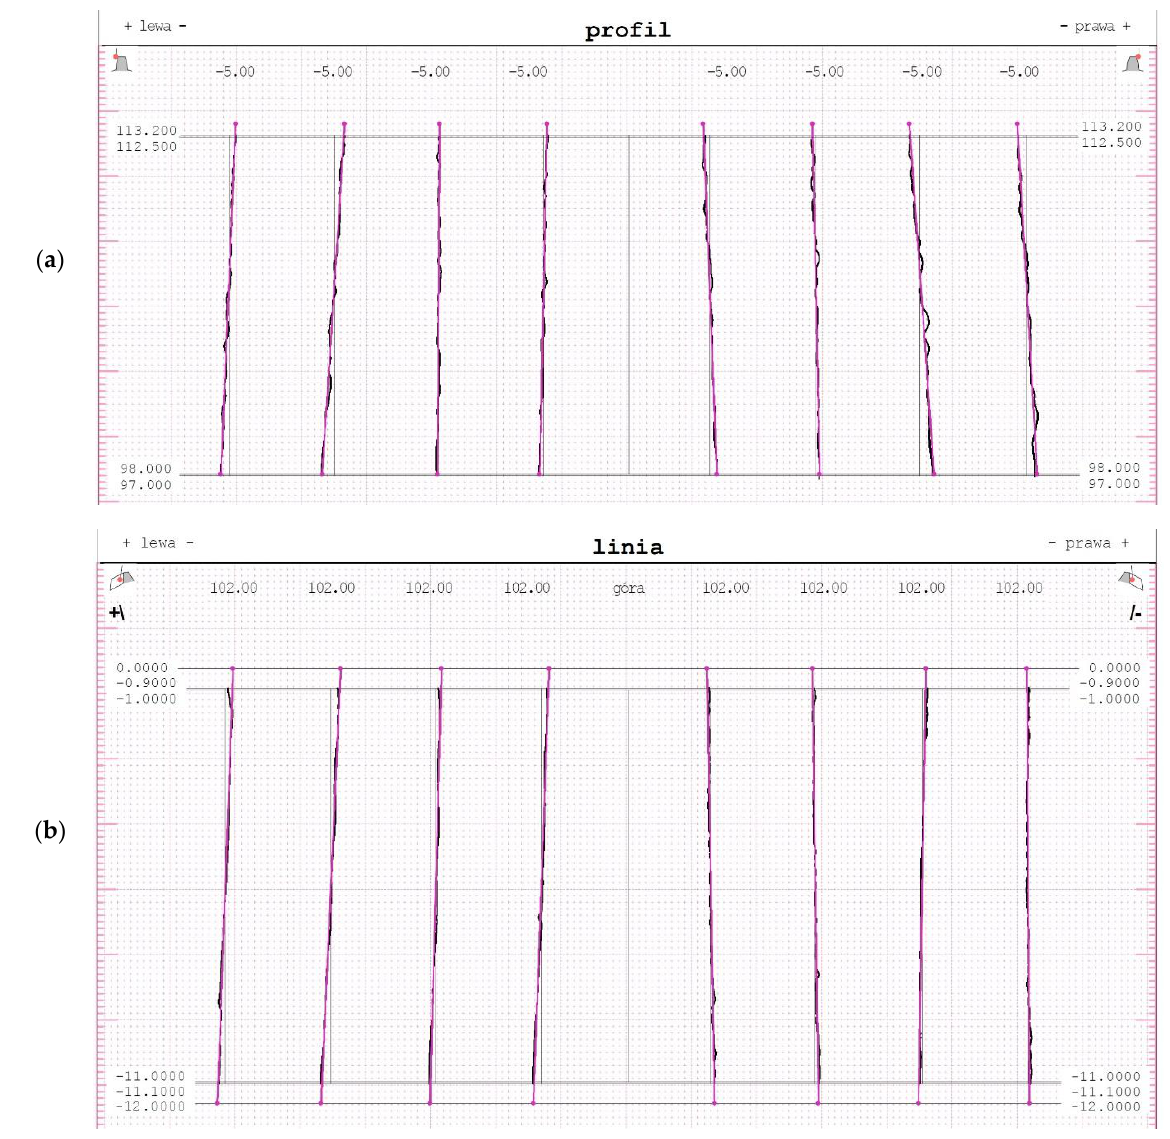
Figure 9. A graphical presentation of the geometrical gear measurement results. ( a ) the profile measurement results, ( b ) the tooth line measurement results.